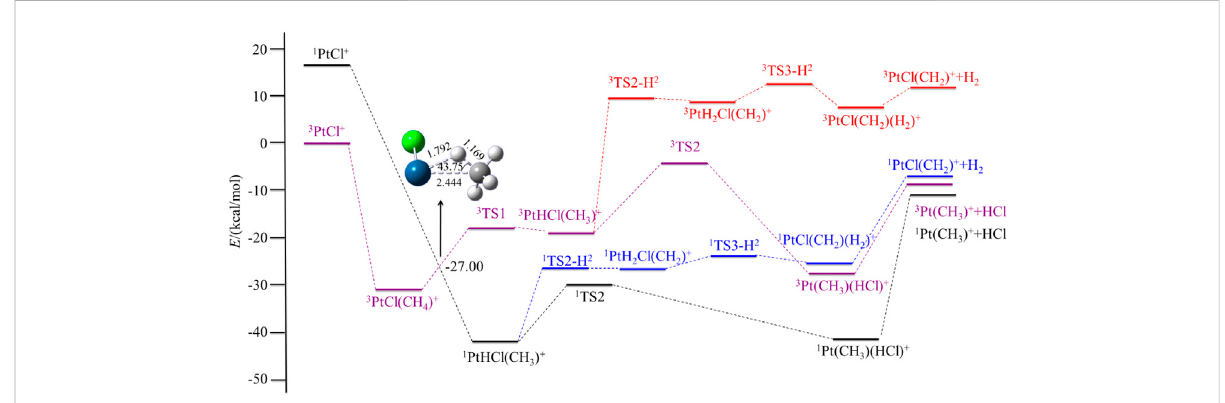
FIGURE 2 Potential energy surfaces of the reaction PtCl + + CH 4 in the low- and high-spin states. The structure is the minimum energy crossing point